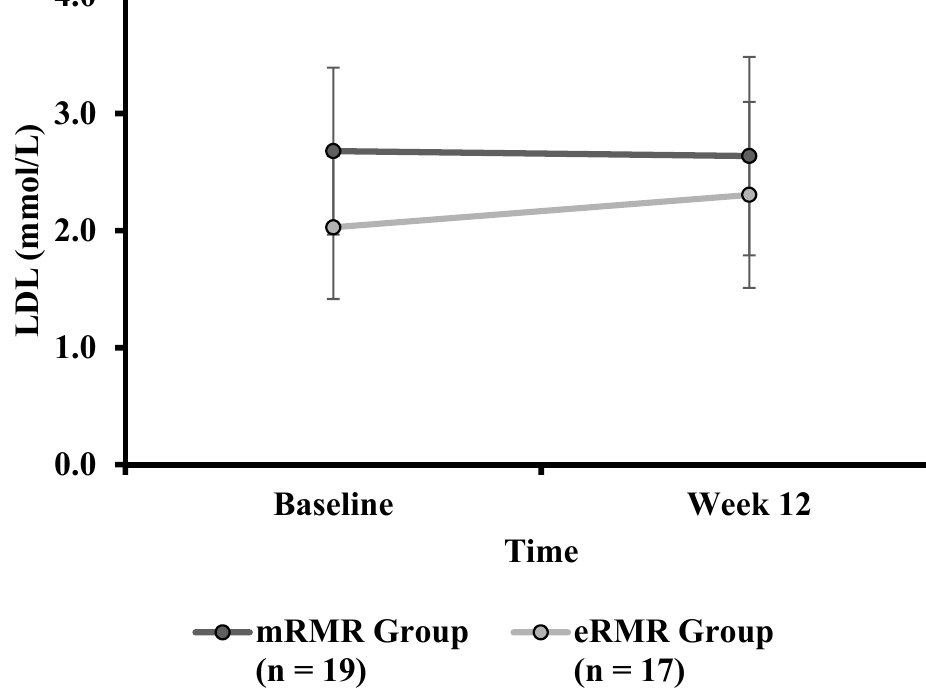
Figure 7. Low-density lipoprotein (mmol/L) calculated at baseline and week 12 for the mRMR ( n = 19) and eRMR groups ( n = 17). 3.17. Triglycerides